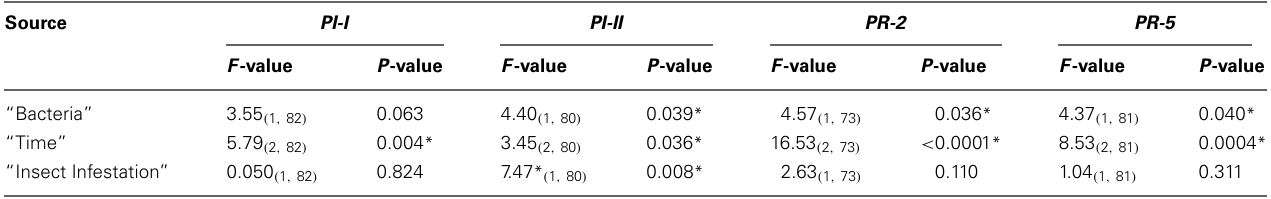
Table A2 | ANOVA results ( F -values and significance) of quantitative real-time PCR (qRT-PCR) analyses (main effects).